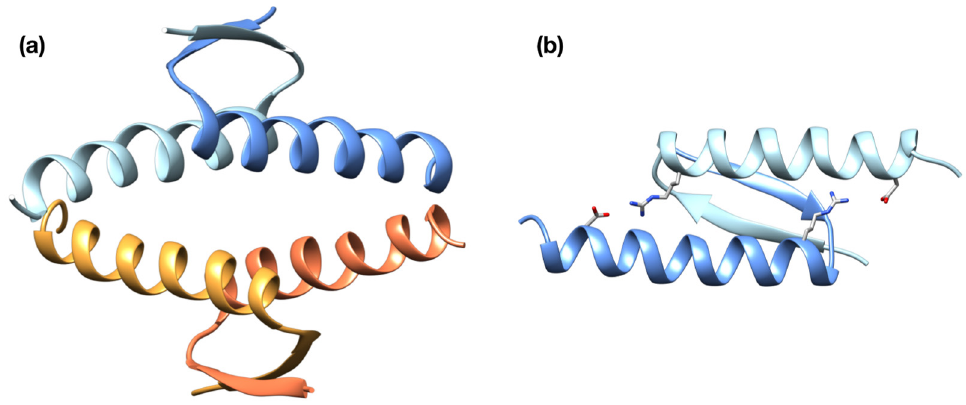
Figure 1. Structure of the p53 TET domain: ( a ) ribbon representation of the fully assembled TET domain of WT p53, where the individual chains are depicted in different colors; ( b ) representation of a dimer of the p53 TET domain displaying the two intermolecular salt-bridges between residues R337 and D352.